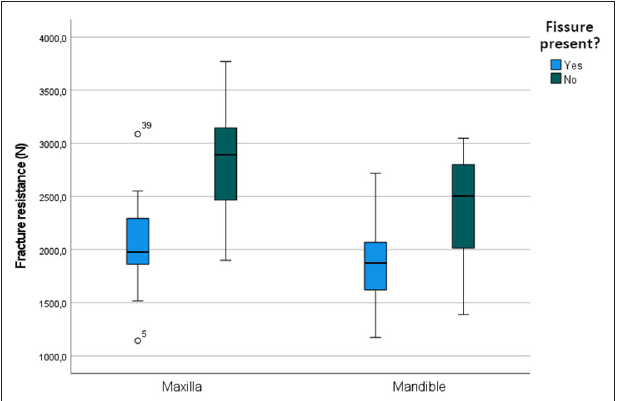
FIGURE 7 | Boxplot illustrating the fracture resistance of cheek teeth with and without fissures present in the maxilla and